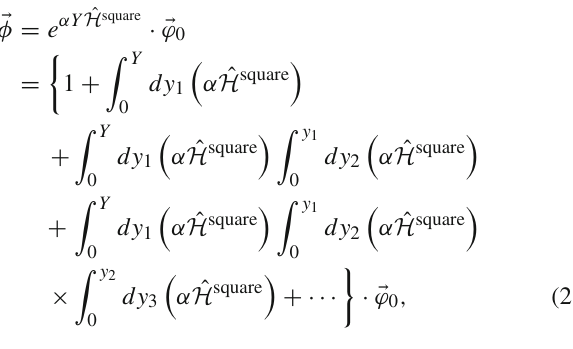
The spectrum of eigenvalues of the square matrix